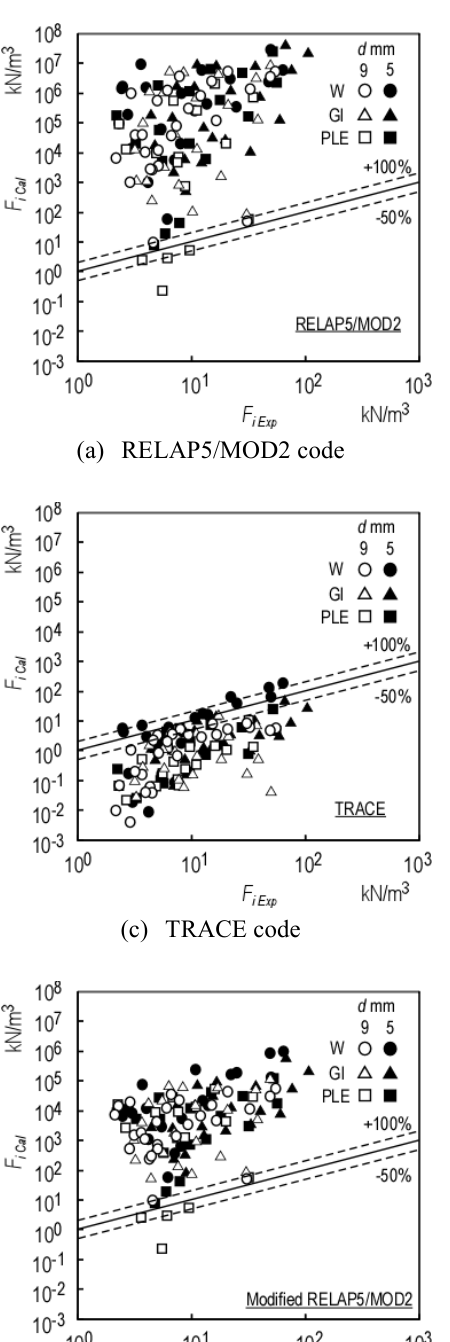
Figure 5 (a) to (g) and Table 4 shows an assessment result of the above 7 F methods in slug flow. code could not predict well the present